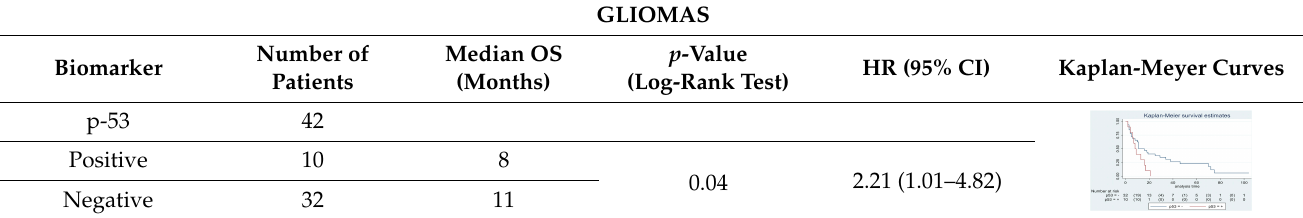
Table 2. Molecular characterization of LGG and HGG with survival estimates. SG and BG samples appear as a unique cohort to reduce the impact that different treatments would have manifested on the results produced. GLIOMAS p -value (Log-Rank HR (95% Biomarker Number of Patients Median OS (months) Test)